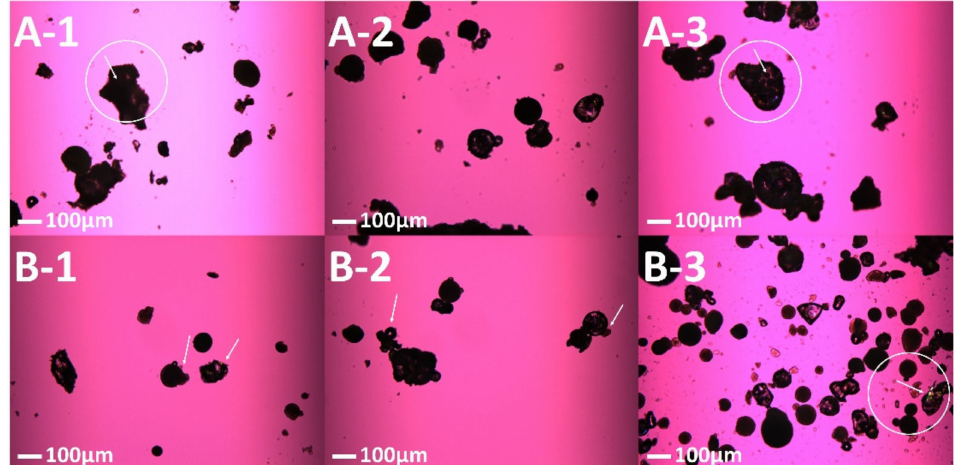
Figure 3. Polarized light microscopy of SLS 3D printed tablets from PFS and UFS ( A-1 ) 50 mm/s PFS, ( A-2 ) 75 mm/s PFS, ( A-3 ) 100 mm/s PFS, ( B-1 ) 50 mm/s UFS, ( B-2 ) 75 mm/s UFS, ( B-3 ) 100 mm/s UFS.